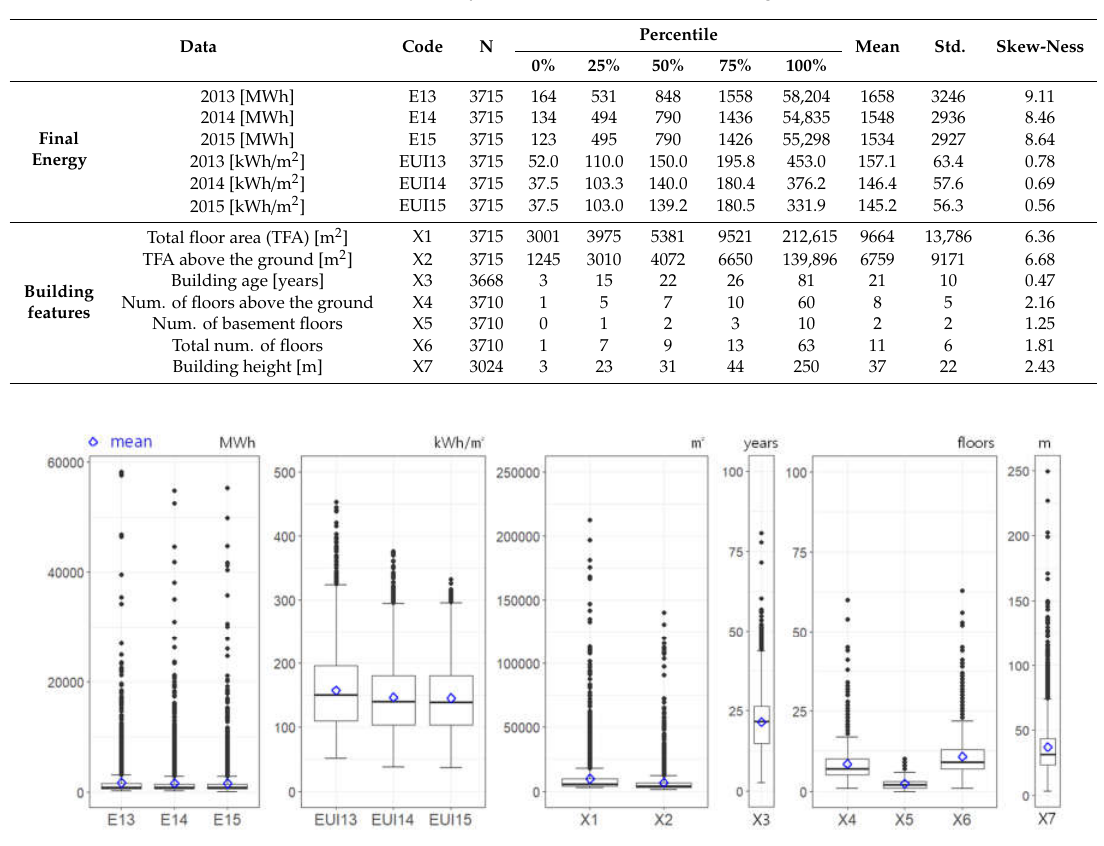
ffi ce building data in